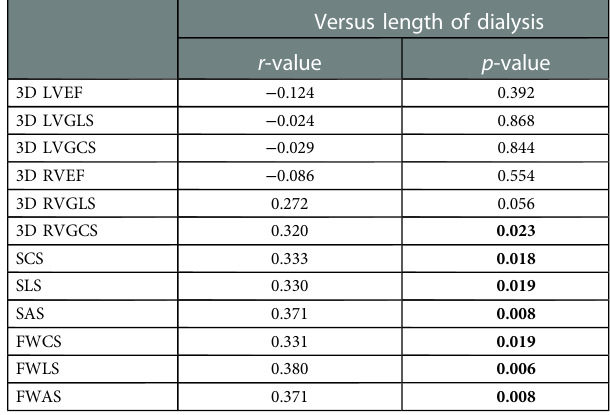
Values with a signi fi cant correlation are presented in bold. LVEF, left ventricular ejection fraction; LVGLS, left ventricular global longitudinal strain; LVGCS, left ventricular global circumferential strain; RVEF, right ventricular ejection fraction; RVGLS, right ventricular global longitudinal strain; RVGCS, right ventricular global circumferential strain; SCS, septal circumferential strain; SLS, septal longitudinal strain; SAS, septal area strain; FWCS, free wall circumferential strain; FWLS, free wall longitudinal strain; FWAS, free wall area